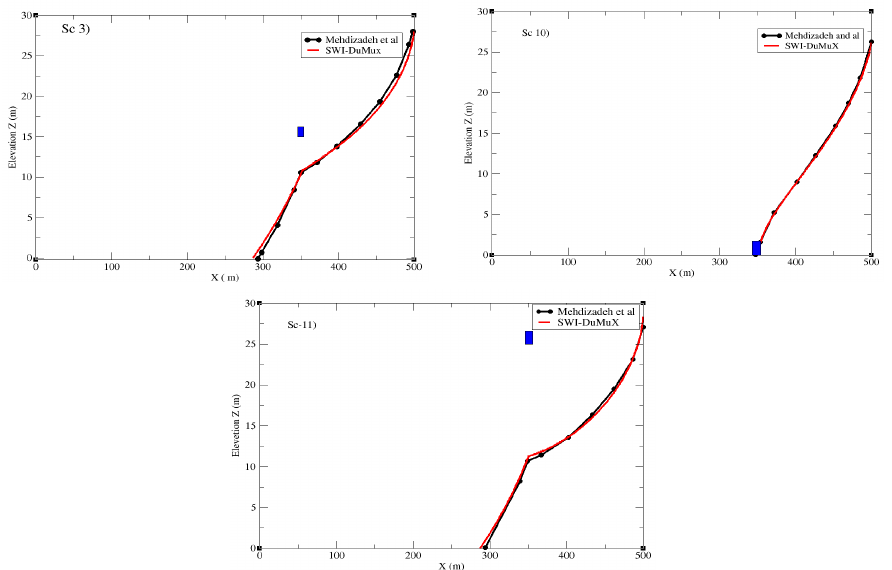
Figure 5. Evolution of the salt front by varying the depth of the well and fixing the pumping rate at 0.07 m 3